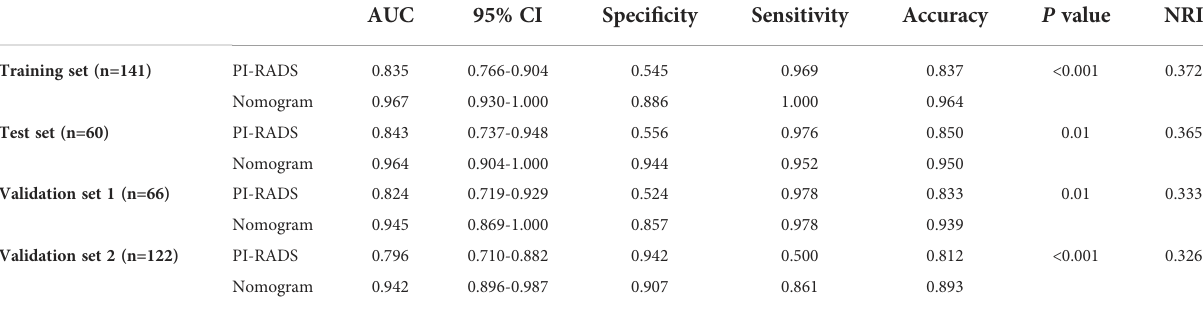
TABLE 5 ROC curve analysis and comparison of prediction models in all data sets.